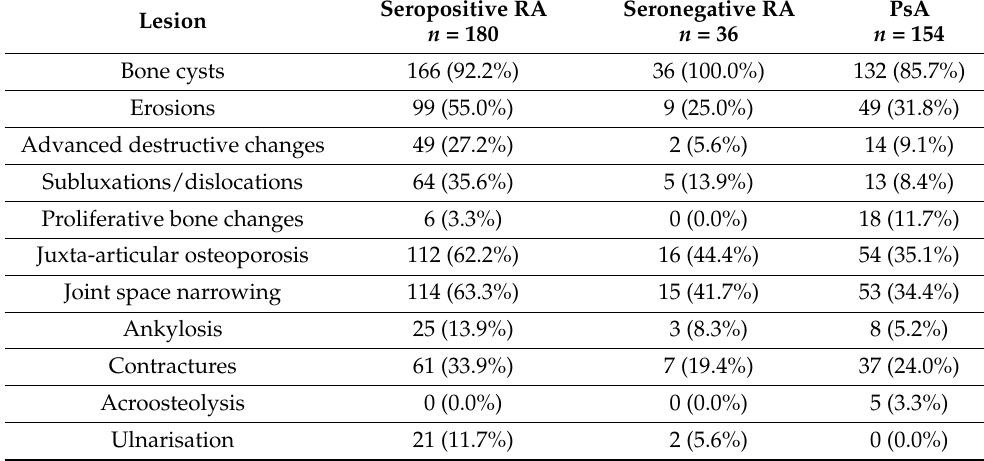
Figure 5. Locations of lesions on hand radiographs of analyzed patients with seropositive RA, seronegative RA, and PsA. Table 4. Types of lesions observed on hand radiographs of analyzed patients with seropositive RA, seronegative RA, and PsA.